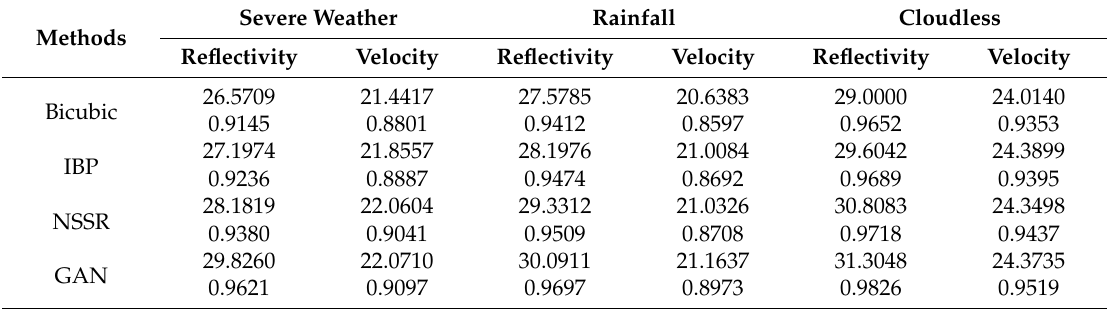
Table 1. Average peak signal-to-noise ratio (PSNR) (dB) and structural similarity index (SSIM) results of the reconstructed echo of five groups of level-II data products of the CINRAD-SA radar ( × 4). IBP: Iterative Back Projection. NSSR: Nonlocal Self Similarity Sparse Representation. GAN: Generative Adversarial Networks.